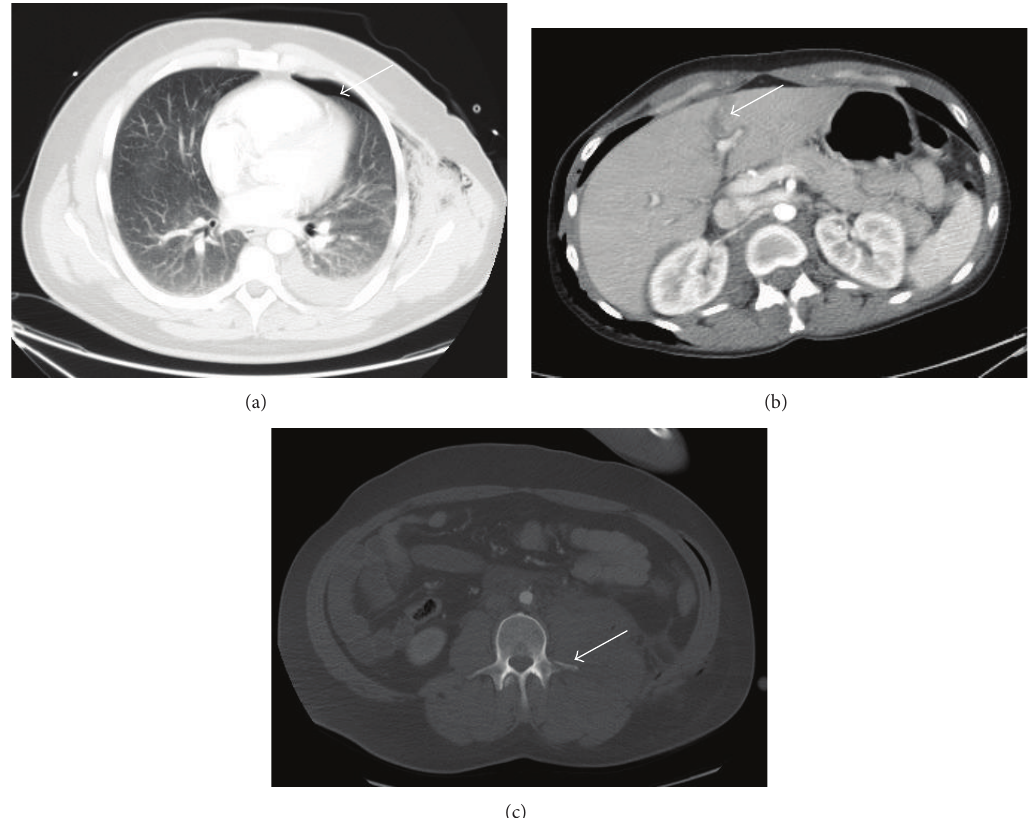
Figure 2: Image acquisition with the routine CT protocol reconstructed by filtered back projection (FBP) without IR. In (a) the white arrow points to a small pneumothorax in the lingula segment. In (b) a hepatic laceration in liver segments 2 and 4a is displayed. Notice the semicircular soft tissue emphysema on the right side. In (c) the arrow points to the fracture of the left transverse process of L3 with no major dislocation and a corresponding haematoma of the psoas